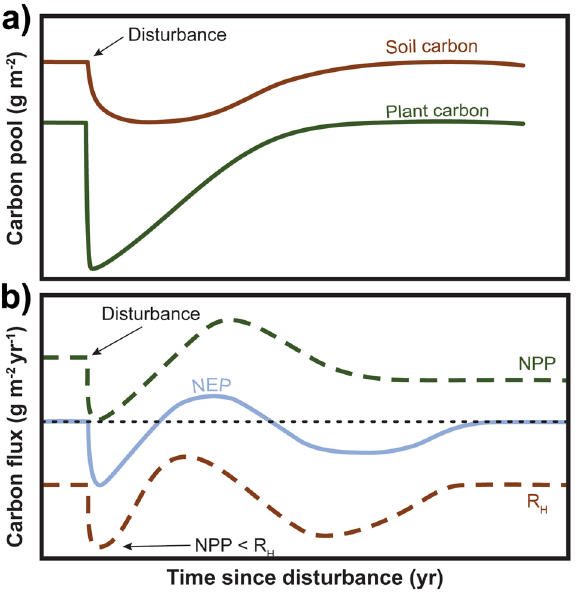
Figure 1. Predicted plant and soil carbon pools and processes following disturbance. Immediately after disturbance, loss of soil organic carbon and plant material are predicted (above panel). Prior to disturbance, net primary productivity (NPP) is in balance with hetetrophic respiration (R H ) such that NEP equals zero. A pulse in respiration (R H ) (bottom panel) is predicted after disturbance such that NPP < R H and NEP is negative (source of carbon to the environment) and eventually the ecosystem comes back into quasi-steady state (modified from Gorham et al. 2